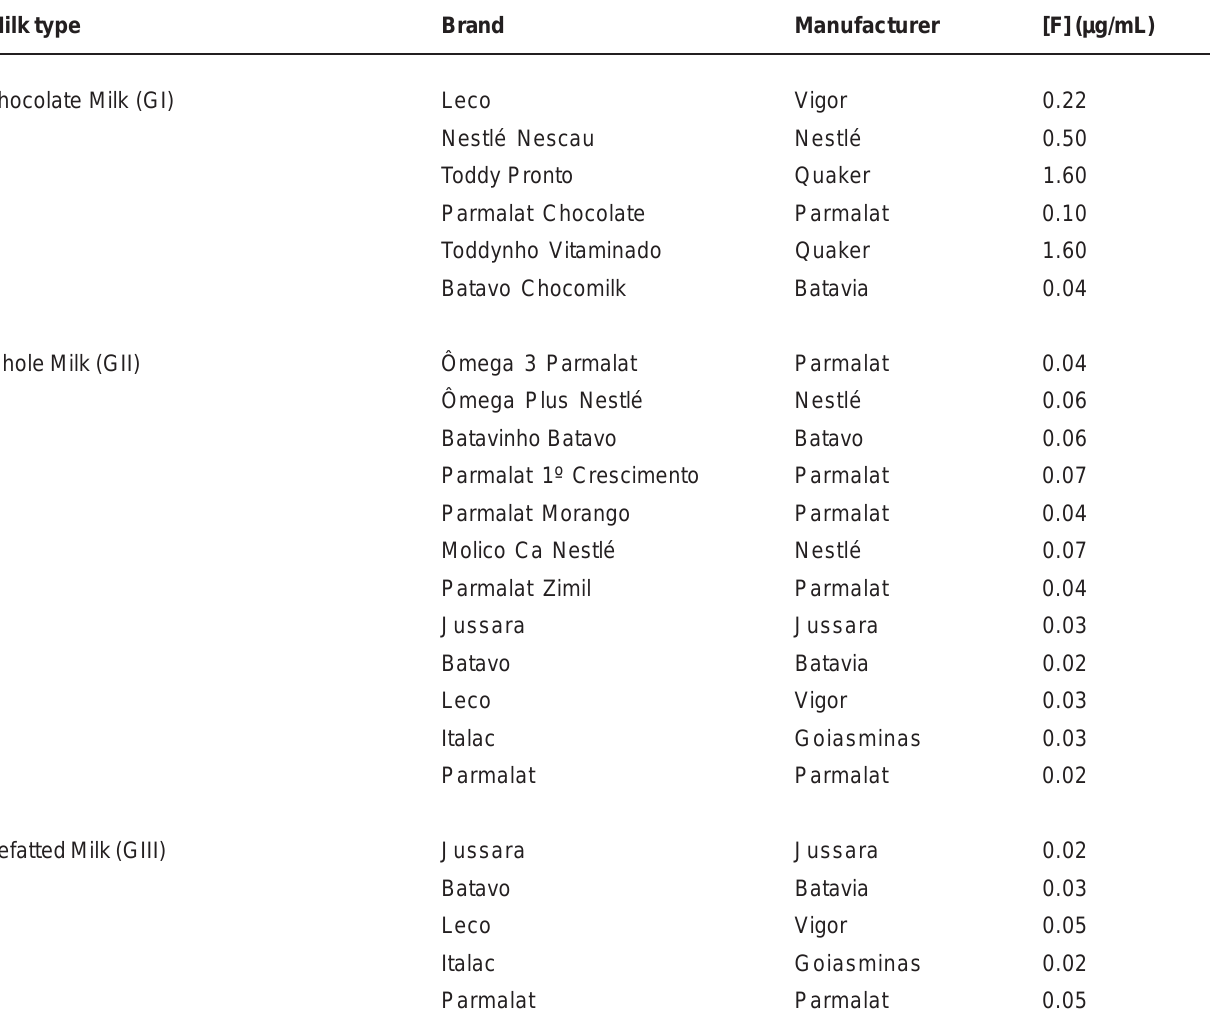
TABLE 1- Fluoride content of the different types of milk analyzed